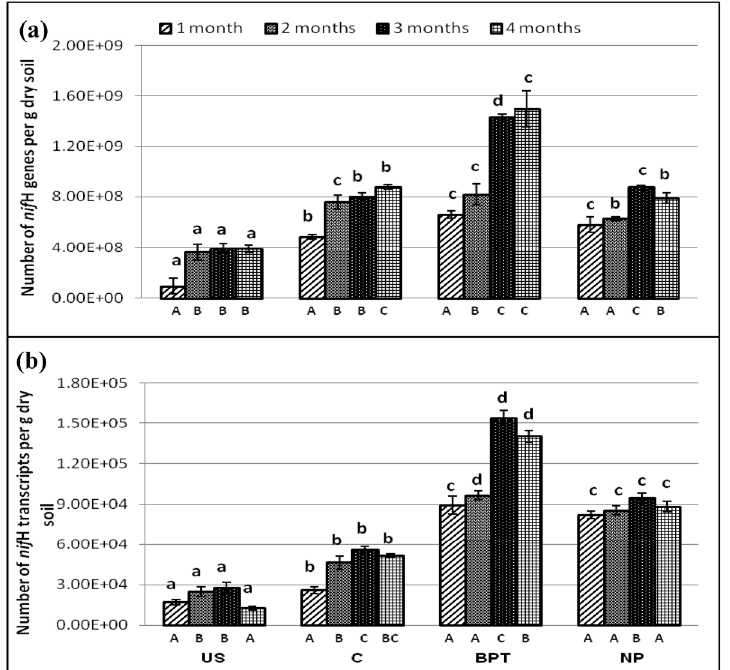
Fig 3. Abundance (copies per g dry soil) of (a) genes (b) transcripts of nitrogenase ( nif H) under different treatments at four time points. Error bars represent standard deviations ( n = 3). Significantly different values (p < 0.05) between different sampling time points in the same treatment are marked by capital letters (A to C) under the columns, and between different treatments for the same time point are marked by lower case letters (a to